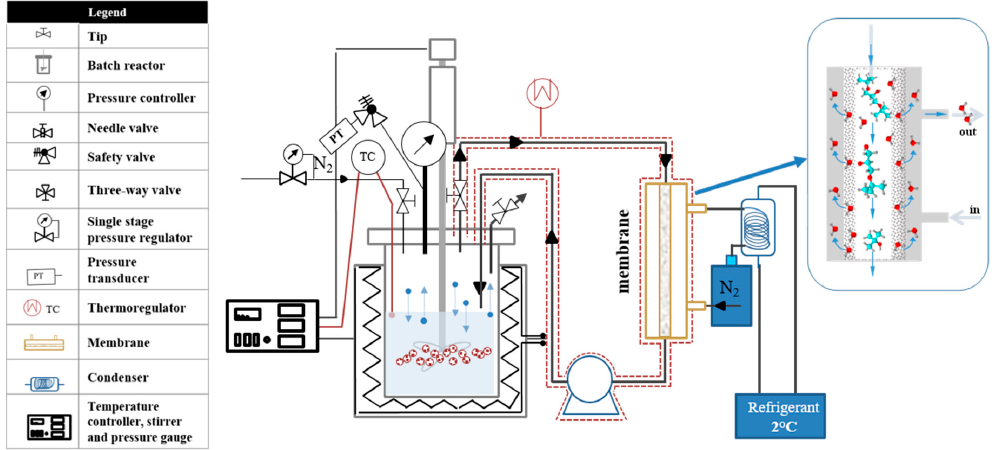
Figure 4. VP-coupled batch reactor for glycerol etherification with TBA.